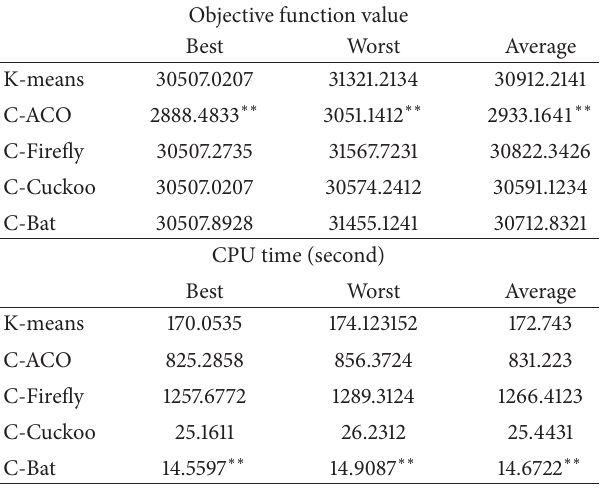
Figure 5: Computation time (in secs.) for C-Firefly, C-Cuckoo, and C-Bat